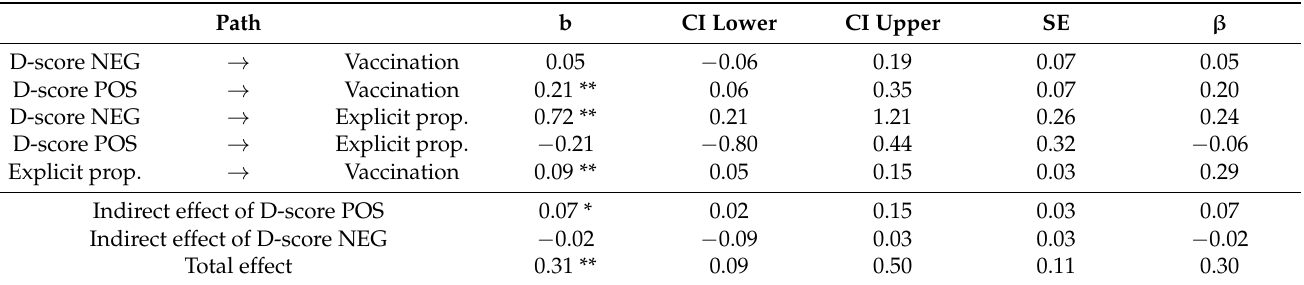
Table 2. Structural path coefficients, indirect and total effect for the mediation model.